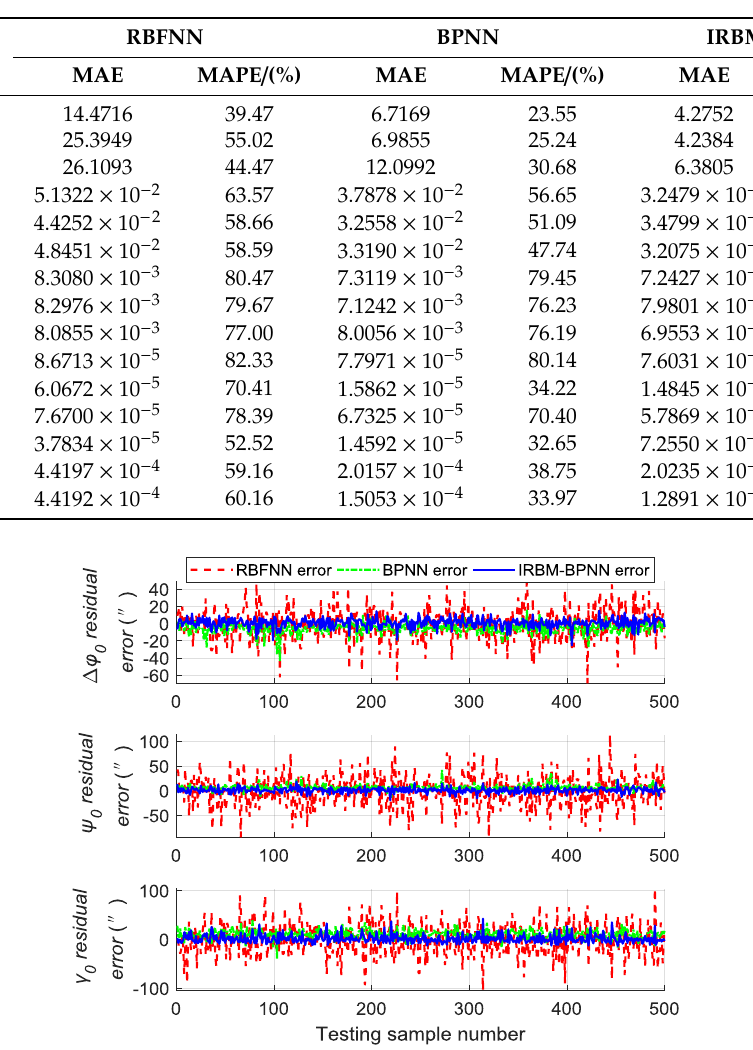
Figure 14. Contrast results of gyroscope residual error using three methods.